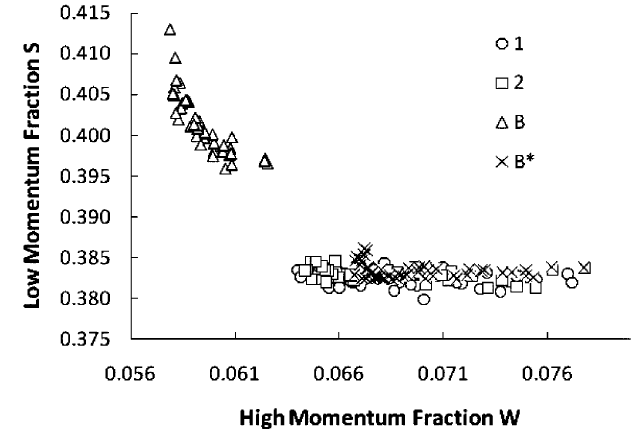
FIG. 9. High momentum annihilation fraction W vs positron energy for unbaked (#1, #2) and baked (#3, #4) single crystal Nb samples.